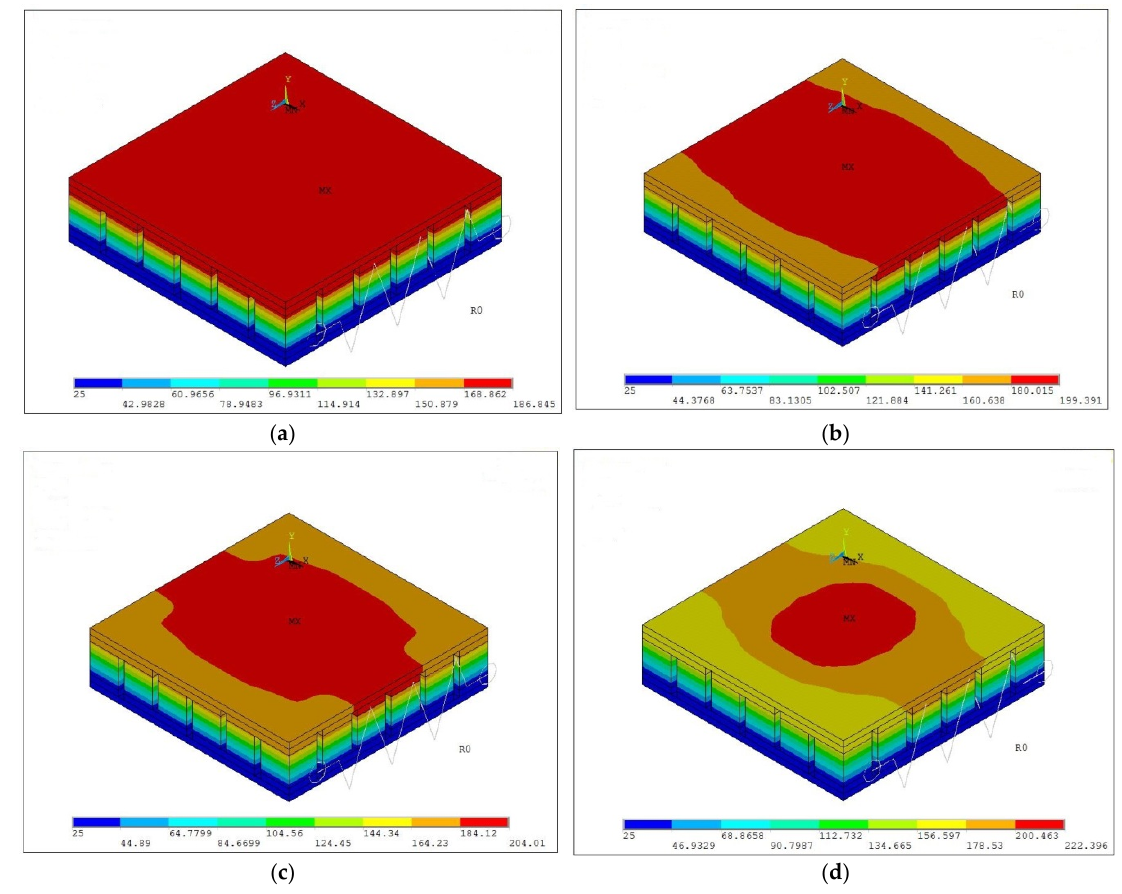
Figure 3. The effect of heating uniformity (U f ) on the temperature distribution of the top surface of the thermoelectric generator (TEG) when P is 22.05 W (Unit: °C): ( a ) U f = 100%; ( b ) U f = 70%; ( c ) U f = 50%; ( d ) U f = 30%.